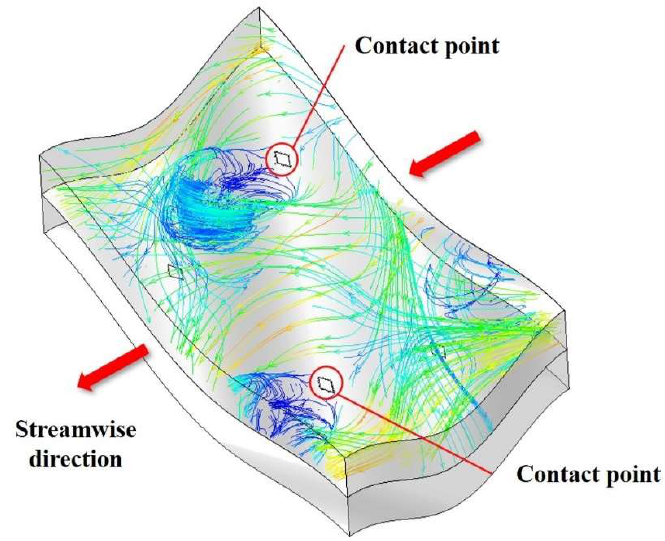
Figure 6. Streamlines in the hot water channel with the sinusoidal configuration.